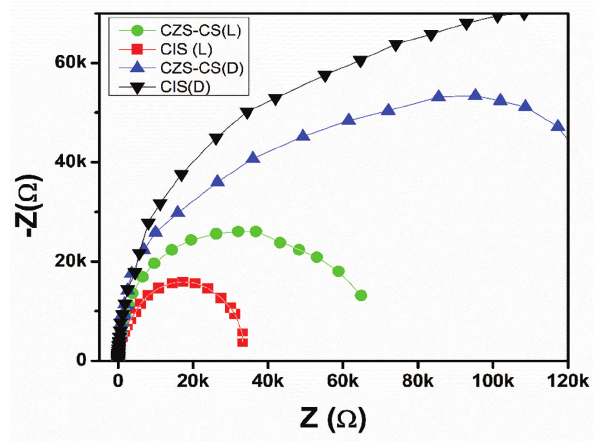
Figure 7: LSV results of fabricated CIS and CZS-ZS composite thin films synthesized via AACVD at 500°C under dark and illumination. Figure 8: EIS plots of CIS and CZS-ZS under dark and